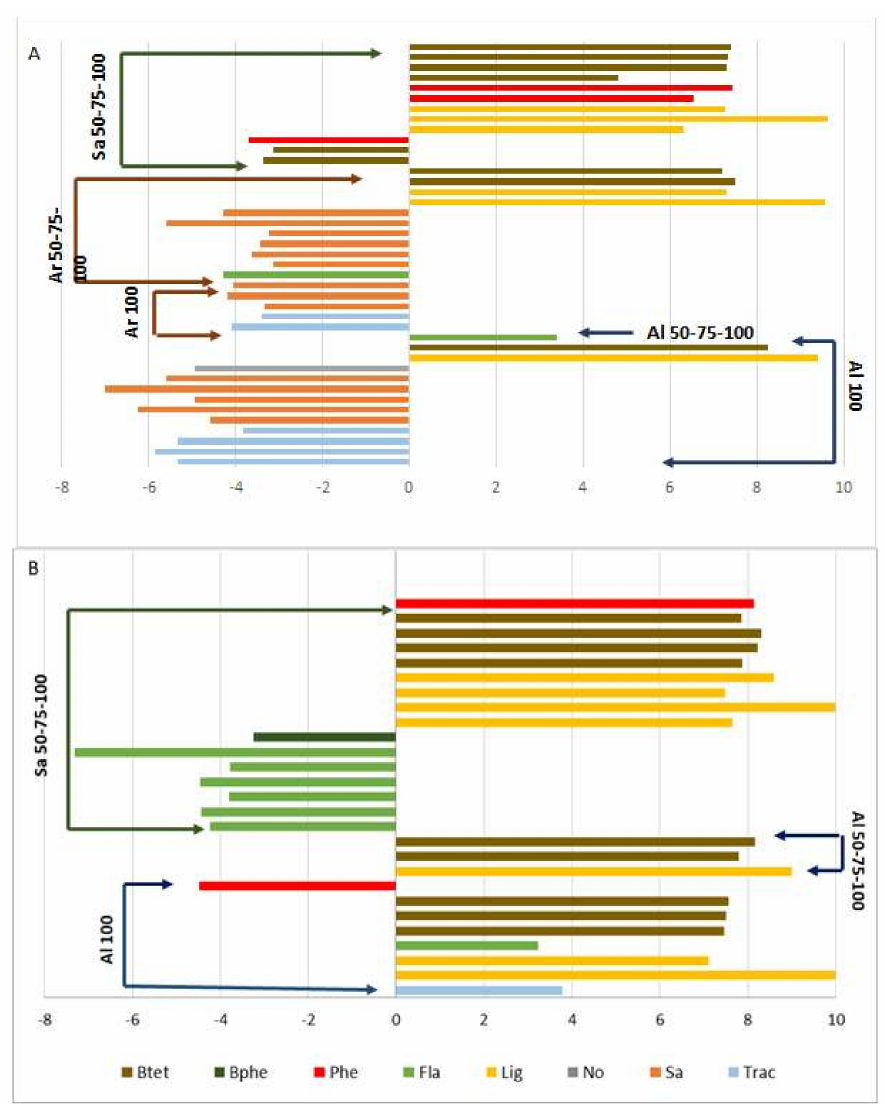
Figure 7. Relative fold changes of differential secondary metabolites for ( A ) roots and ( B ) shoots of M. sativa (Sa), M. arborea (Ar) and Alborea (Al) under salt stress and salt shock treatments. Btet = benzyl tetrahydrofuran, Bphe = Biphenyl, Phe = Phenol, Fla= Flavonoid, Lig = Lignan, Sa = Saponins, Trac = Triterpenic acid, No = No